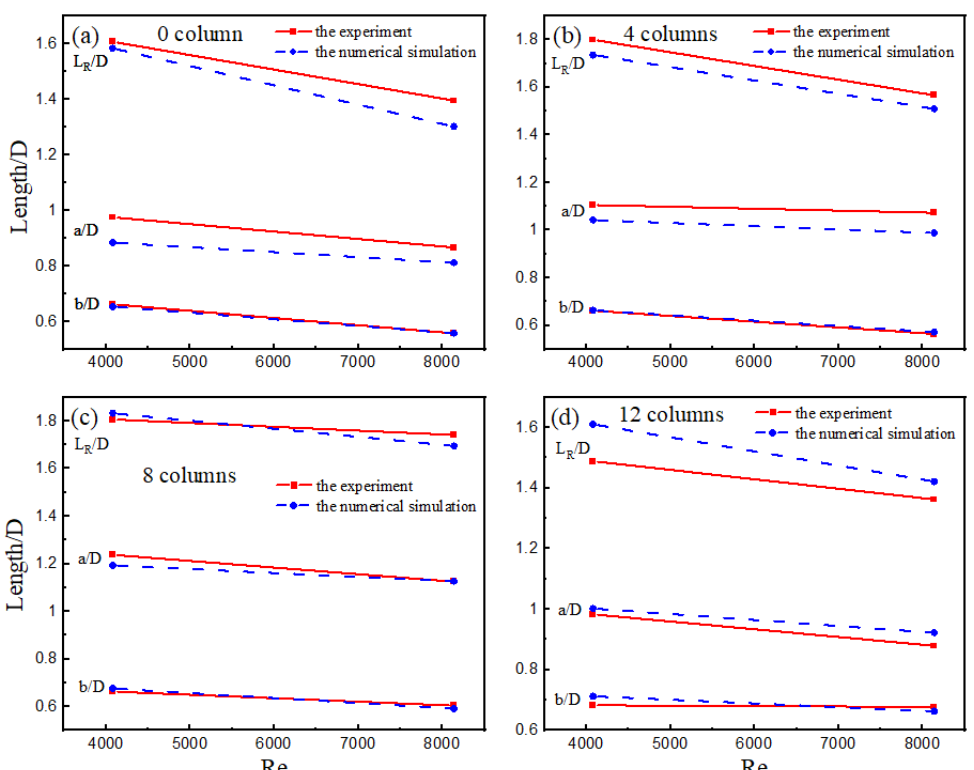
Figure 13. Variation of the normalized length scales of the cylinders with respect to Re : ( a ) the smooth cylinder; ( b ) the cylinder with 4 columns of dimples; ( c ) the cylinder with 8 columns of dimples; ( d ) the cylinder with 12 columns of dimples.